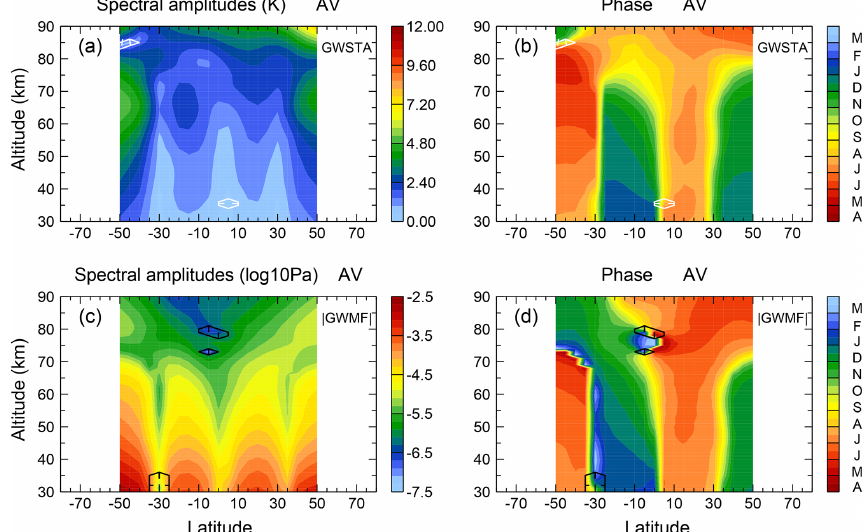
Figure 2. Altitude–latitude cross sections of spectral amplitudes ( a, c , color code in kelvin) and phase ( b, d , color code in months) for annual variation in square root of monthly zonal mean GW square temperature amplitudes and absolute GW momentum flux. Regions “downhill” of the white and black contour (in the direction of the ticks) are regarded as nonsignificant (i.e., values remain below 1.3 times the average spectral